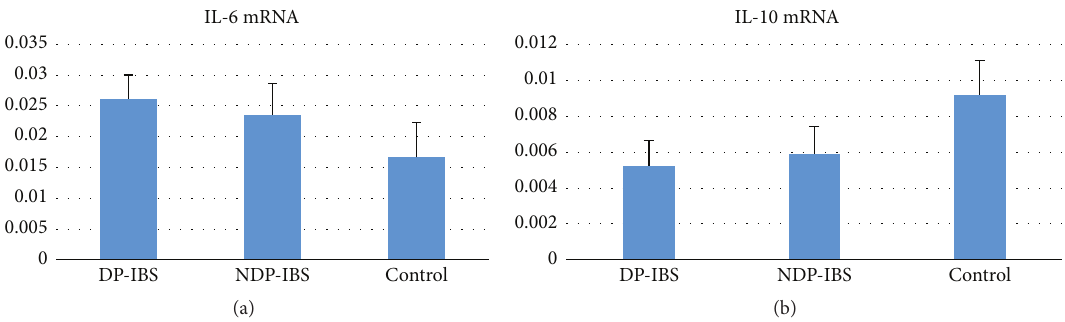
Figure 1: (a) IL-6 mRNA expression between DP-IBS, NDP-IBS, and the control group ( 0.026±0.004 , 0.023±0.005 , and 0.017±0.006 , resp., 𝐹 = 53.077 , 𝑃 < 0.01 ). IL-6 mRNA levels in DP-IBS and NDP-IBS patients were significantly higher than those in the control group. IL-6 mRNA levels in DP-IBS patients were significantly higher than that in NDP-IBS patients ( 𝑃 < 0.05 ). (b) IL-10 mRNA expressions in DP-IBS and NDP-IBS patients were significantly lower than those in the control group ( 0.0092 ± 0.0019 , 0.0059 ± 0.0015 , and 0.0052 ± 0.0014 , resp., 𝐹 = 58.249 , and 𝑃 < 0.05 ). IL-10 mRNA level in DP-IBS is lower than NDP-IBS, but there was no statistical significance ( 𝑃 > 0.05 ).